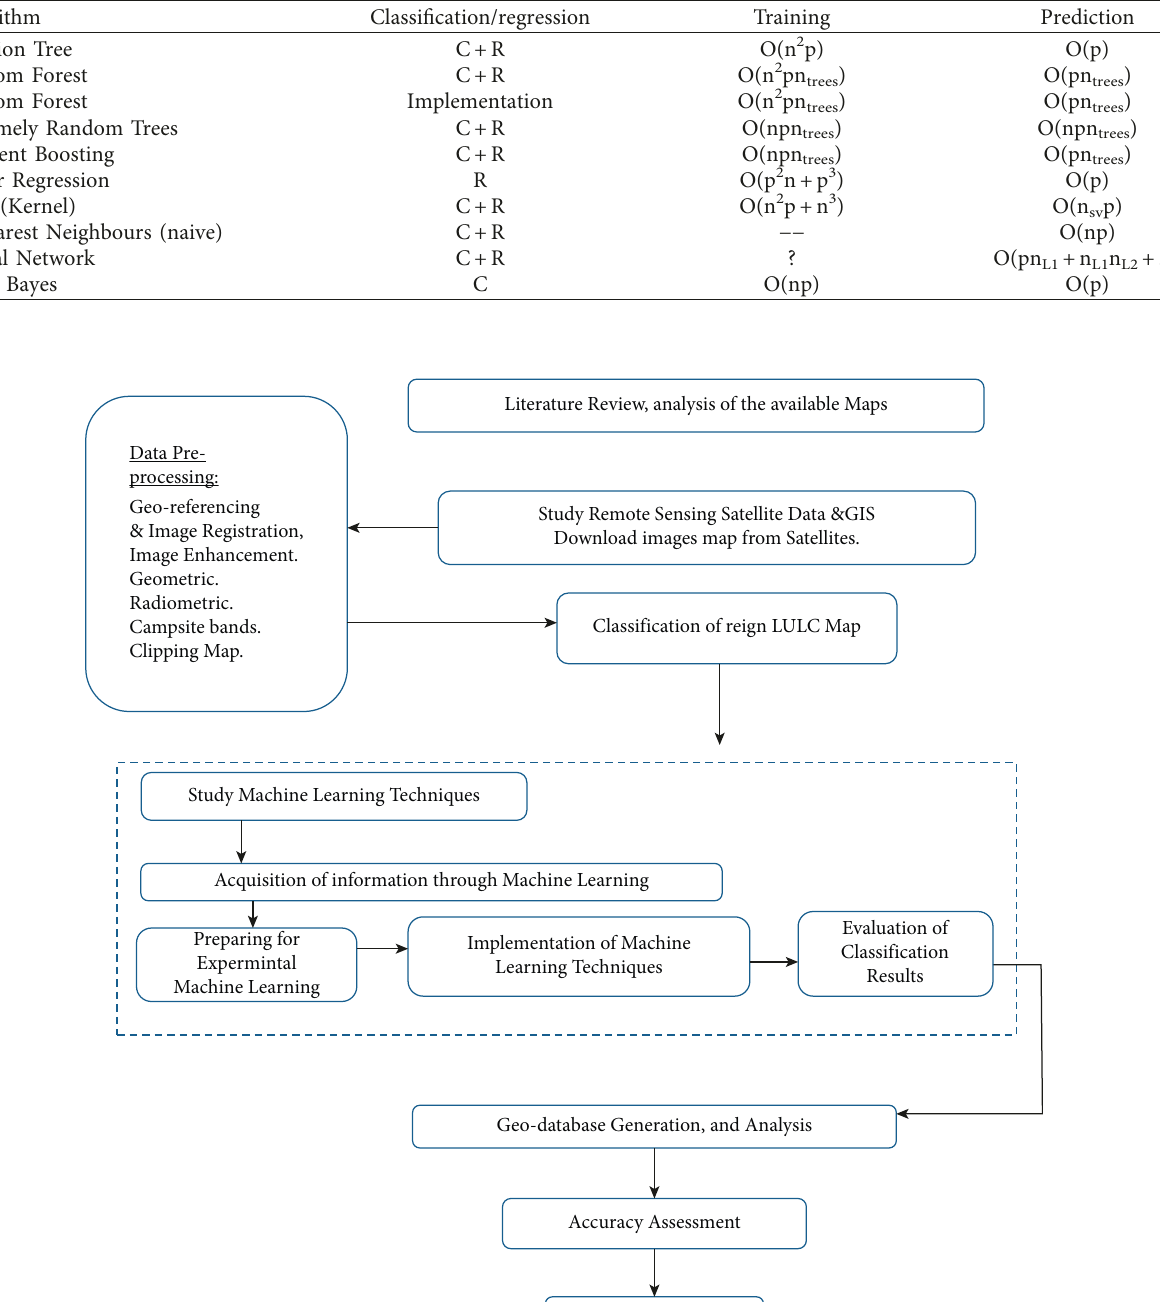
Table 3: Computational complexity for some of machine learning methods [46].